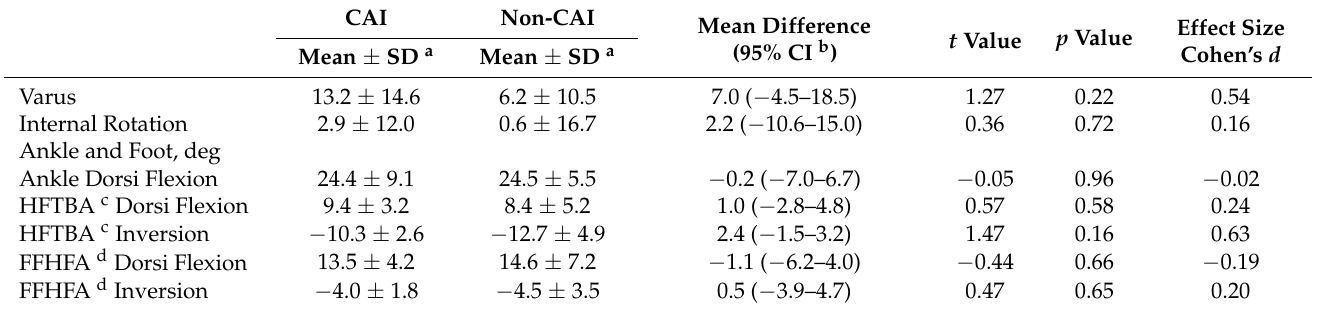
5 Table 3. The maximum values of the lower-extremity kinematics of the CAI and the Non-CAI groups. CAI